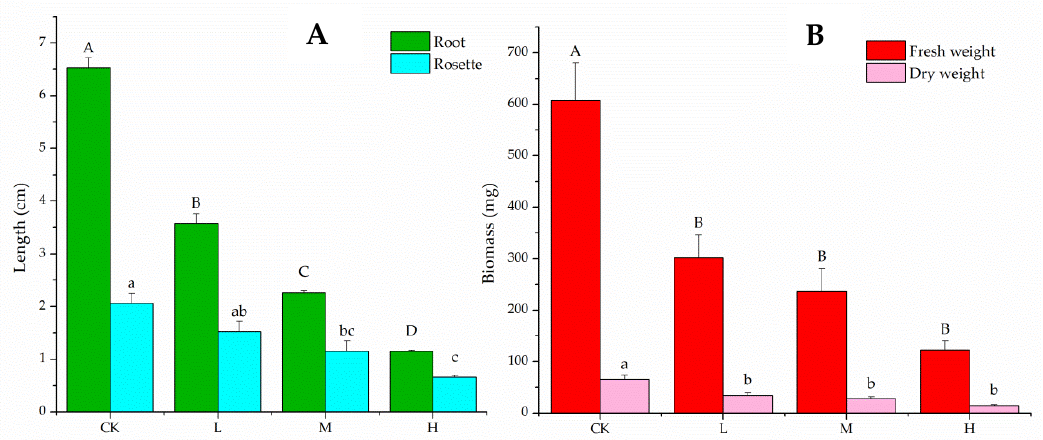
Figure 2. Means and SE values are shown for effects of Eupatorium adenophorum aqueous extracts on root and rosette leaf length ( A ), and biomass ( B ) of Arabidopsis thaliana . Abbreviations: CK–control; L–medium with low concentration extract; M–medium with medium concentration extract; H–medium with high concentration extract. Bars with different letters indicate significant differences at p < 0.05 (Tukey ′ s HSD test).